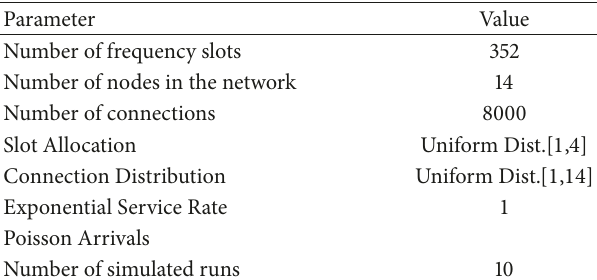
Table 2: Simulation